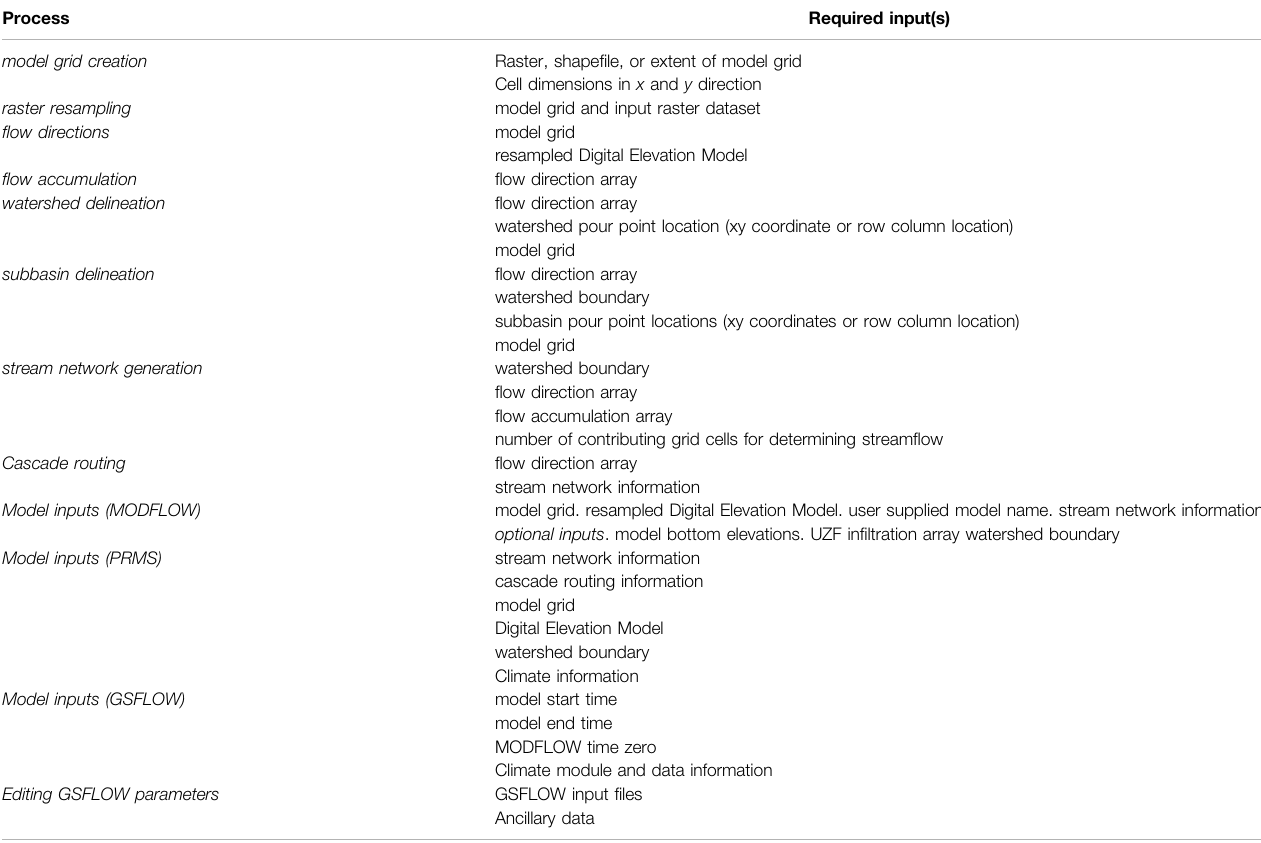
TABLE 1 | Overview of the pyGSFLOW process types and the required input data to create a simple GSFLOW model.